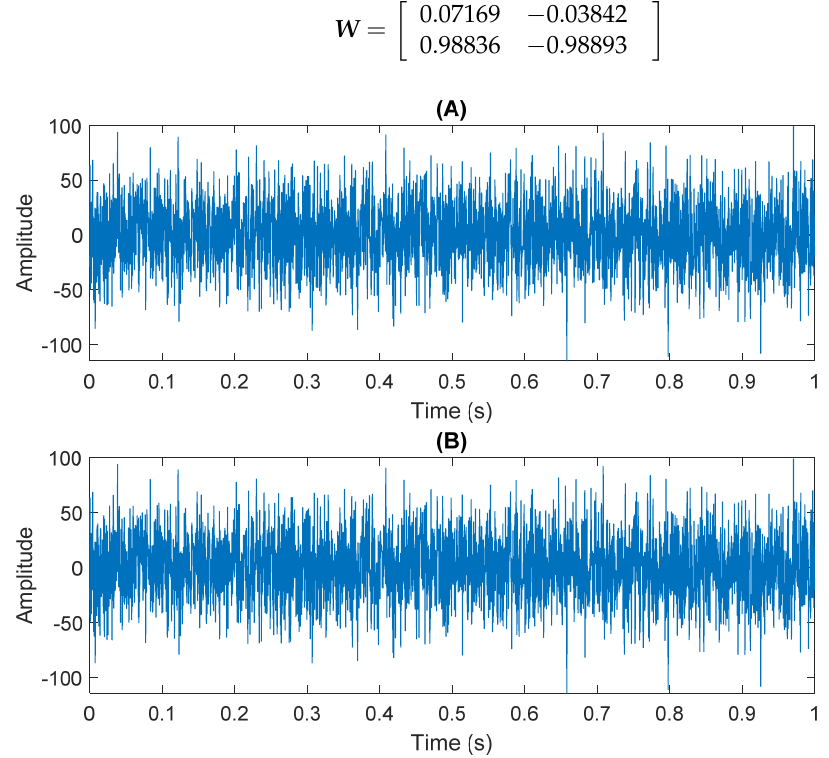
Figure 12. The numerical simulation of data received by two sensors: ( A ) In Equation (30) the sensor signal x1. ( B ) In Equation (30) the sensor signal x2.